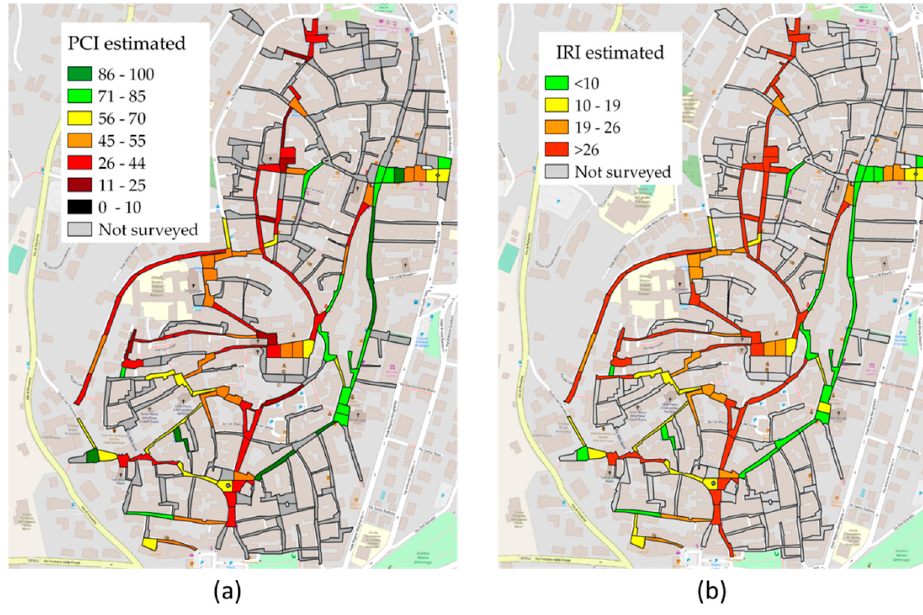
Figure 21. ( a ) PCI and ( b ) IRI estimated for the surveyed network using regression models.